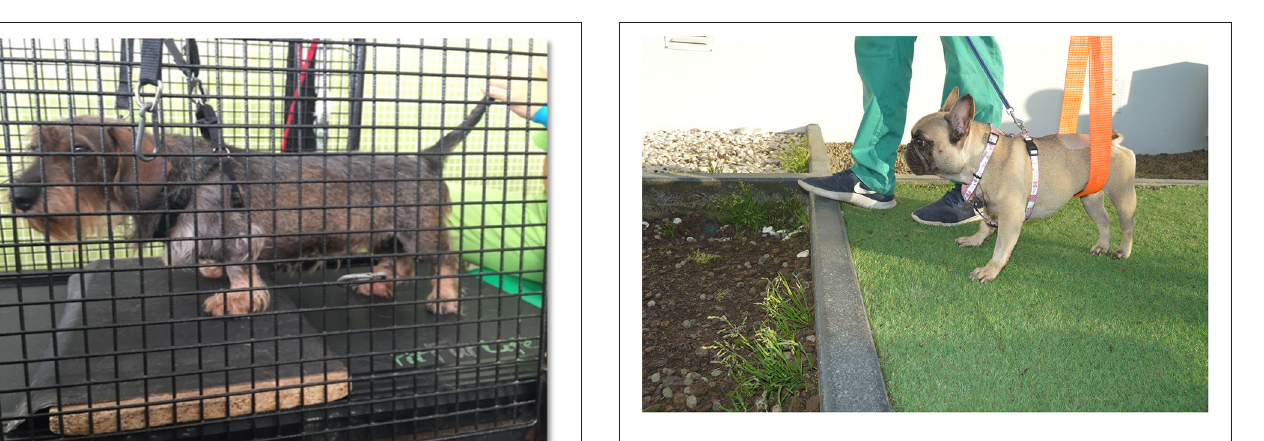
• Speeds of 1–2.5 km/h, during 20–30 min, 2–3 times/day,